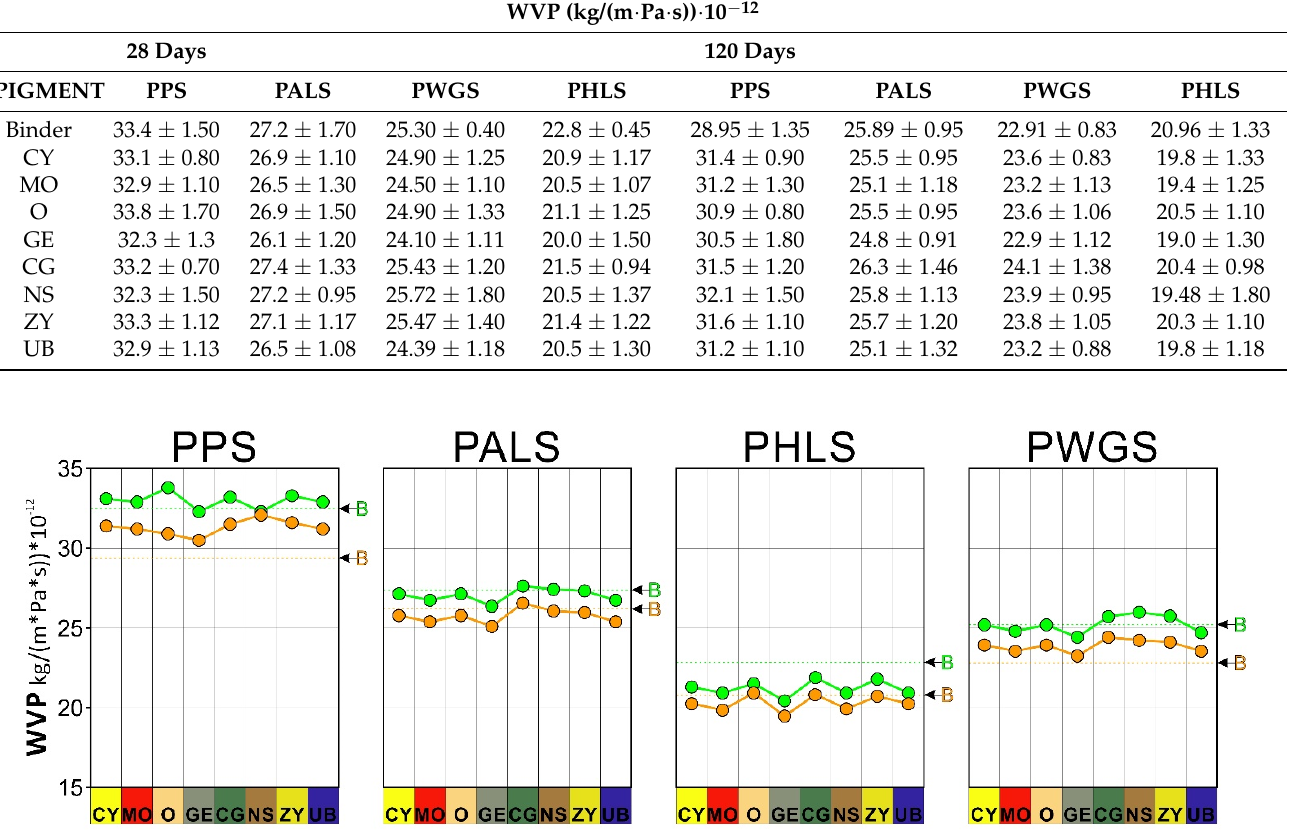
Figure 4. Water vapor permeability of the binders and their corresponding pigmented pastes (PPS, PALS, PHLS and PWGS). The green circles and the orange circles correspond to the permeability at 28 and 120 days respectively. The dotted line and the green letter B correspond to the specific binder at 28 days. The dotted line and the orange letter B correspond to the specific binder at 120 days. After 28 days, the average permeability for the PPS + PIGMENT samples was 33kg/(m·Pa·s))·10 − 2 . The maximum value was 33.3 ± 1.12kg/(m·Pa·s))·10 − 12 for the sample containing the ZY pigment, and the minimum value was 32.3 ± 1.3kg/(m·Pa·s))·10 − 12 for the sample containing the GE pigment.